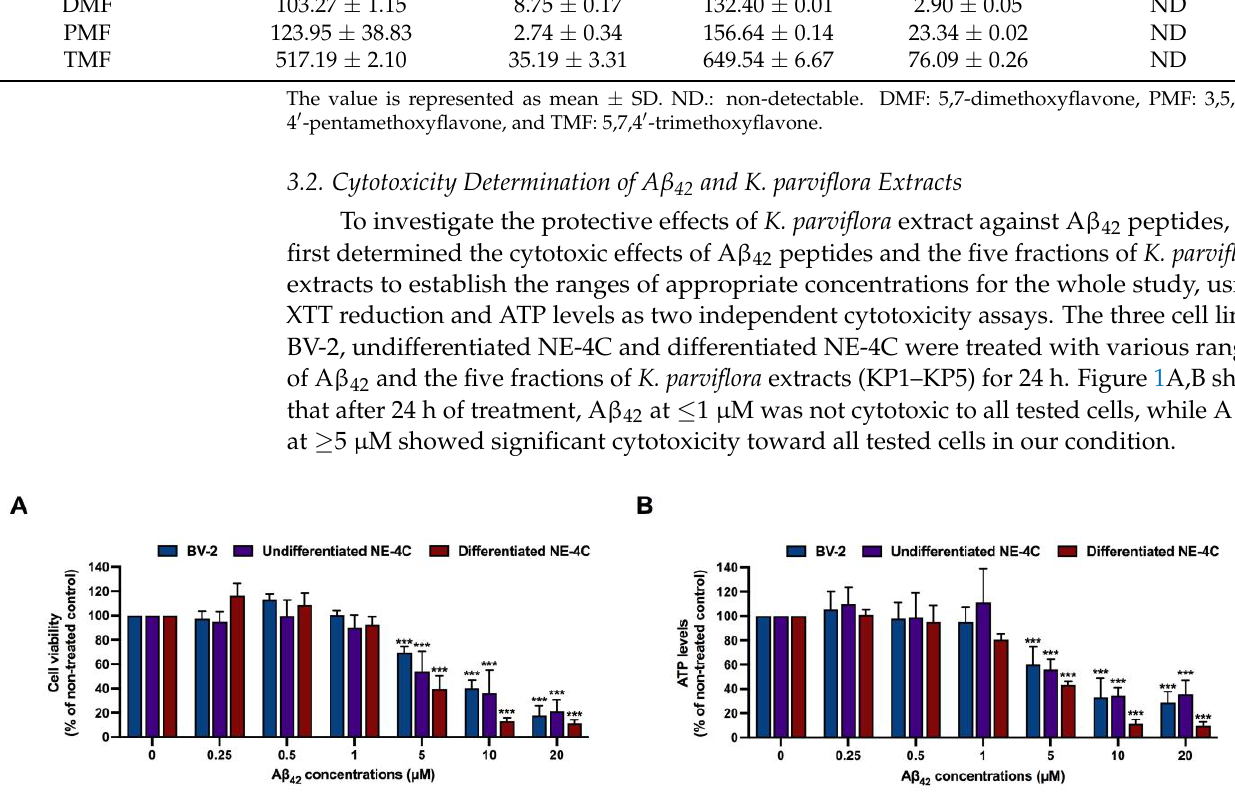
Figure 1. Cytotoxicity effects of amyloid beta peptides (A β 42 ) on BV-2 cells, undifferentiated NE-4C and differentiated NE-4C. ( A ) cytotoxicity effects of A β 42 measured by XTT assay and ( B ) cytotoxicity effects of A β 42 measured by ATP assay. The values are mean ± SD of three independent experiments and statistical significance was analyzed against untreated control (0 µ M) of each cell line using one-way ANOVA followed by Tukey’s test. ***, p <